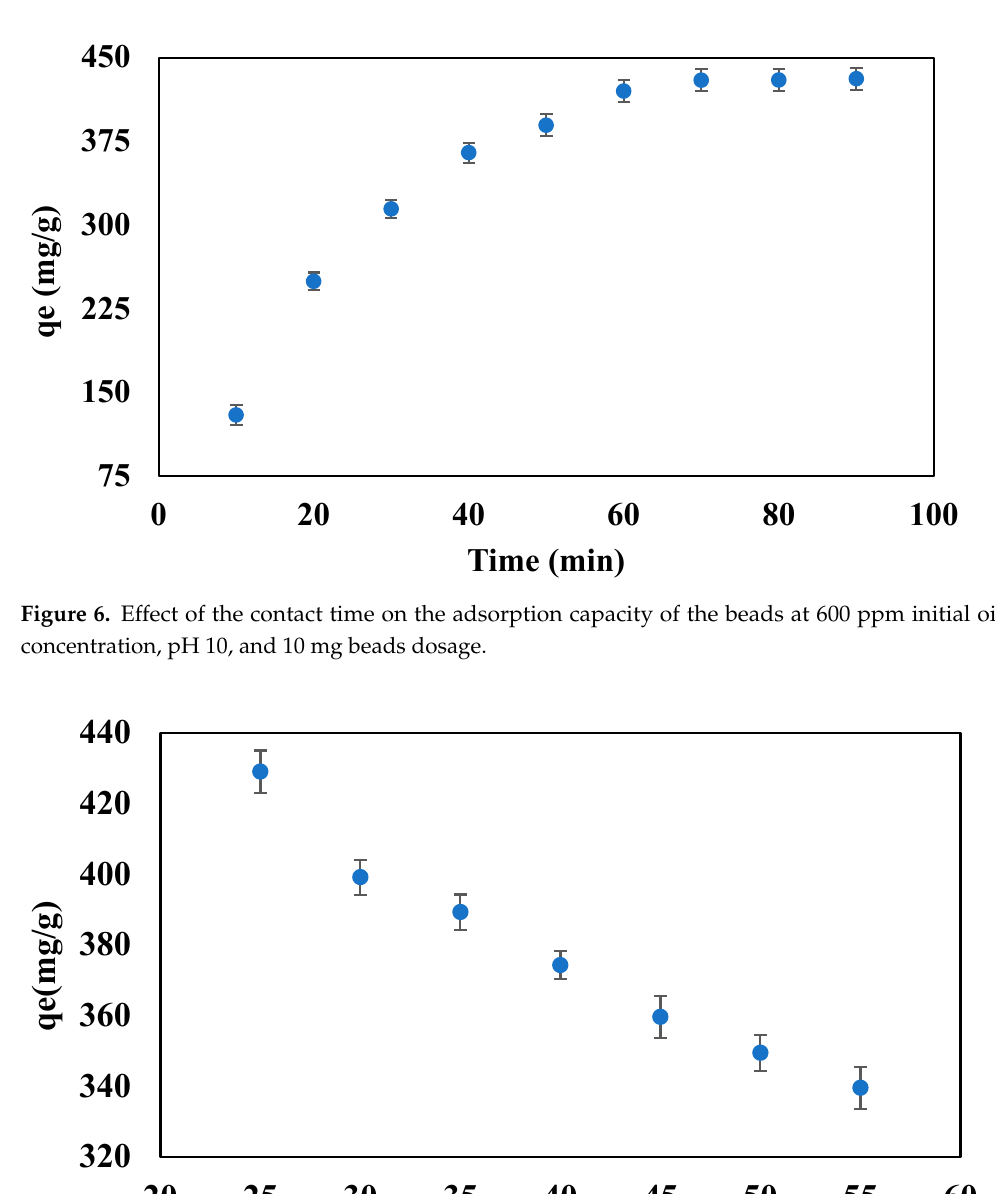
Figure 6. Effect of the contact time on the adsorption capacity of the beads at 600 ppm initial oil concentration, pH 10, and 10 mg beads dosage.